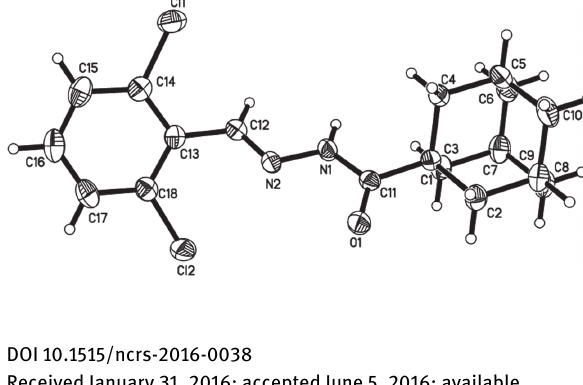
Table 2: Fractional atomic coordinates and isotropic or equivalent isotropic displacement parameters (Å 2